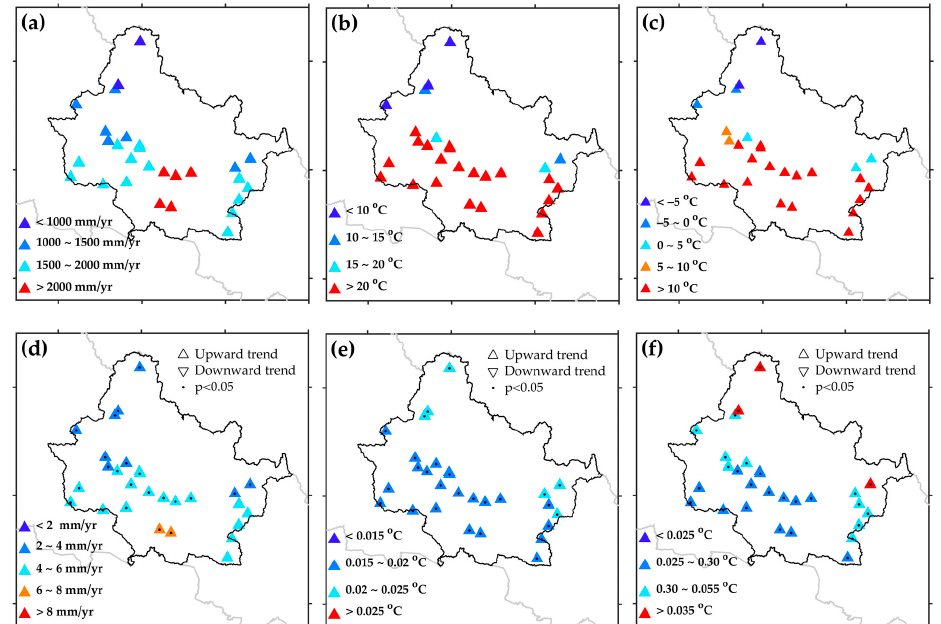
Figure 2. Spatial distribution and trend of mean annual precipitation ( a , d ), Tmax ( b , e ) and Tmin ( c , f ) in CMIP6 (historical) over GRB from 1985 to 2014. Black dot represents significant at 95% confidence level.